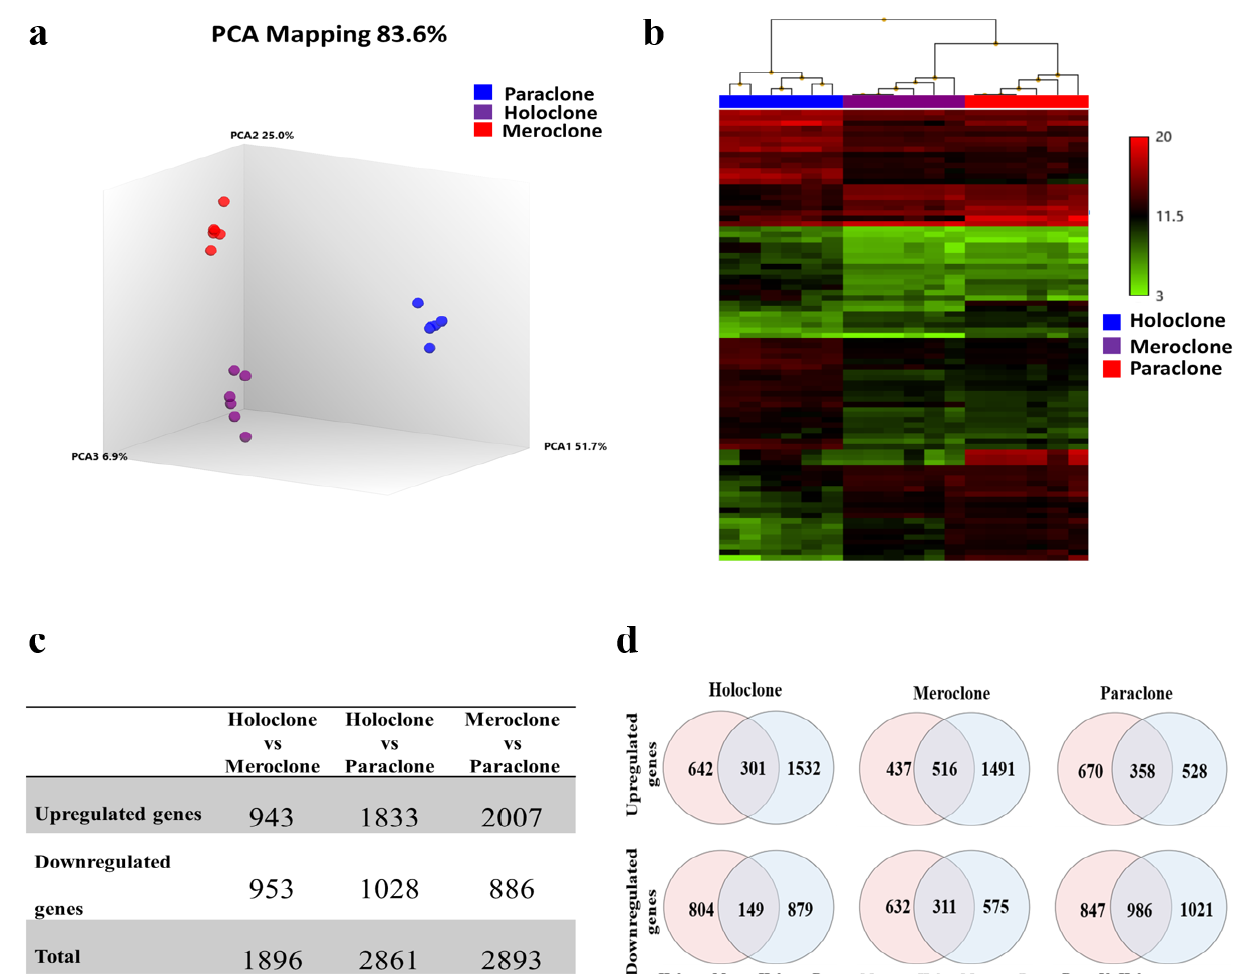
Figure 2. Snapshot microarray analysis of holoclones, meroclones, and paraclones. ( a ) Principal component analysis (PCA) of all the colony types profiled. Holoclones (indicated by purple color) were clustered distinctly from meroclones (indicated by red color) and paraclones (indicated by blue color). The percentage values indicate the proportion of total variance described by each PCA. PCA1 ( X -axis); PCA 2 ( Y -axis); PCA 3 ( Z -axis). ( b ) The hierarchal cluster also separated the KSCs (holoclones) from their progenies (meroclones and paraclones). ( c ) Total number of differentially expressed genes for each clonal type compared to others. ( d ) Two-way Venn diagrams for specifically up and downregulated genes in holoclones, meroclones, and paraclones. The number in the middle of each of the two circles represents the number of specifically up- or downregulated genes in each clonal type.